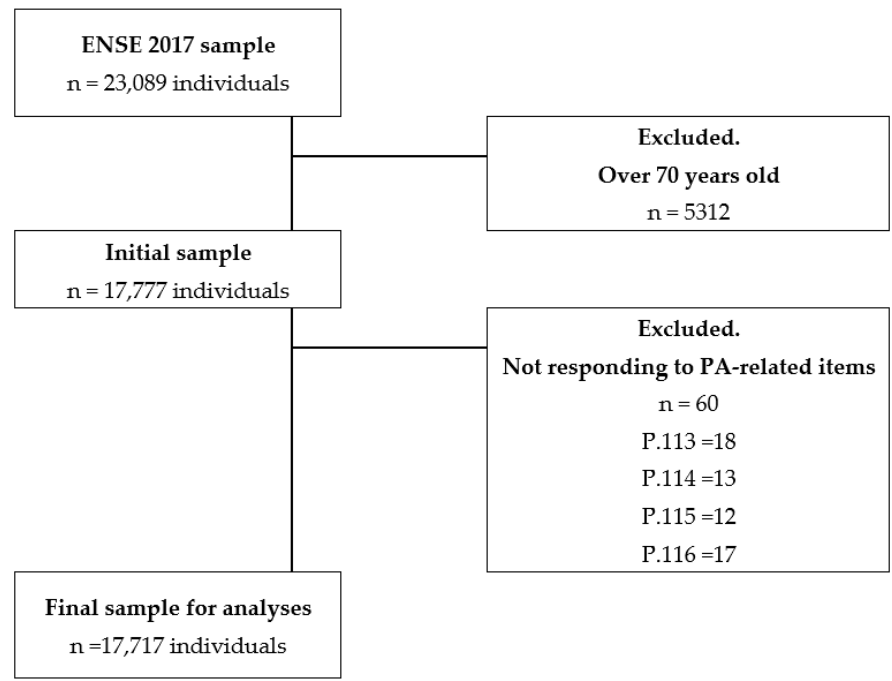
Figure 1. Sample exclusion